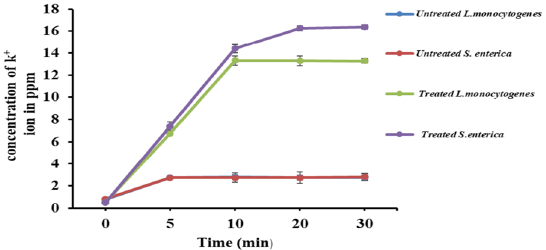
Fig. 2 Efflux of potassium ions from S. enterica and L. monocytogenes cells after the treatment of different concentrations of ESmr18. Untreated S. enterica and L. monocytogenes cells were used as controls. Error bars are representative